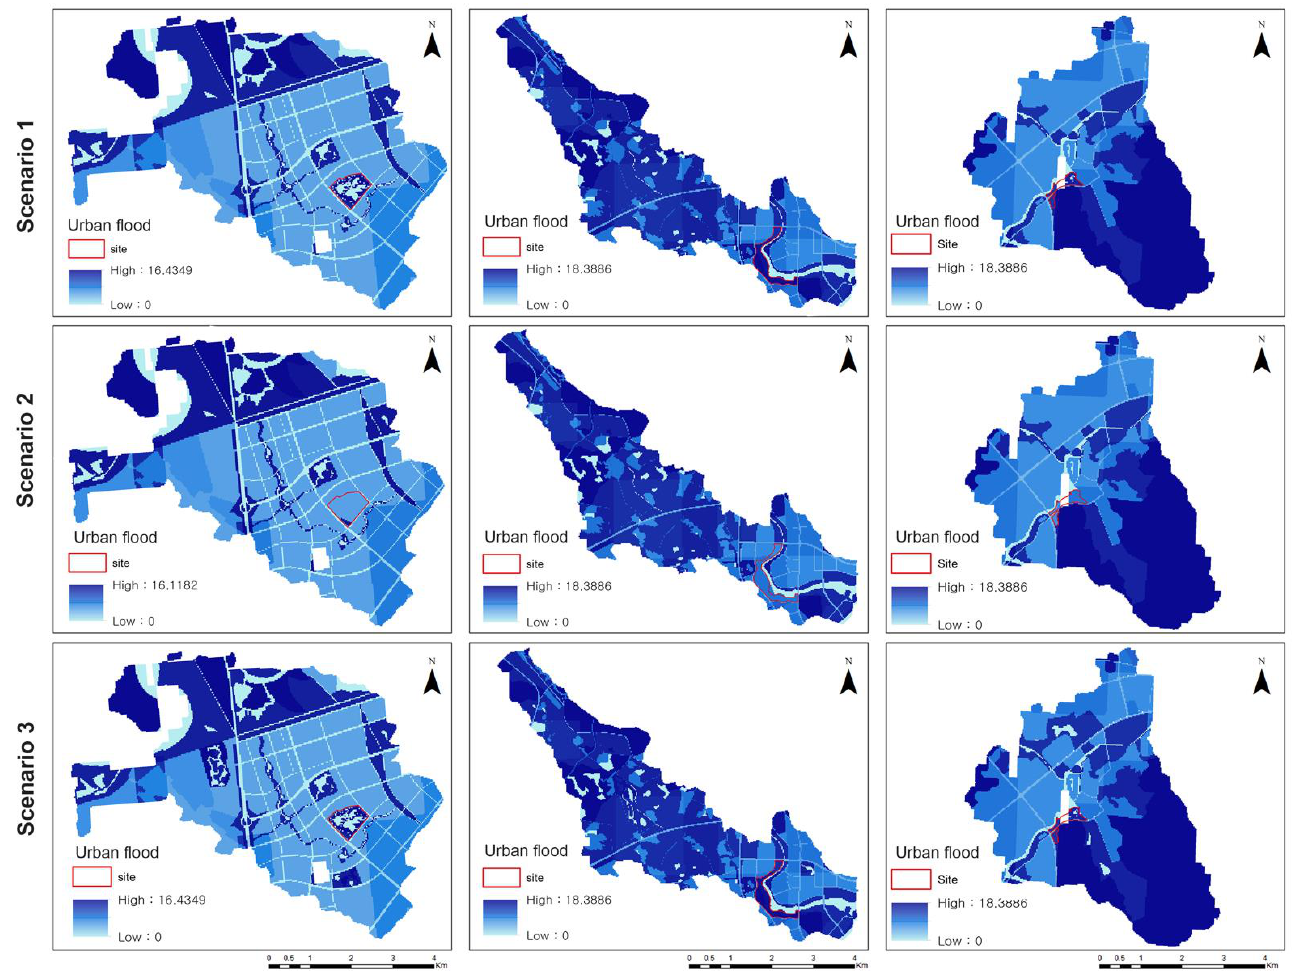
Figure 6. Spatial distribution of the urban flood retention.